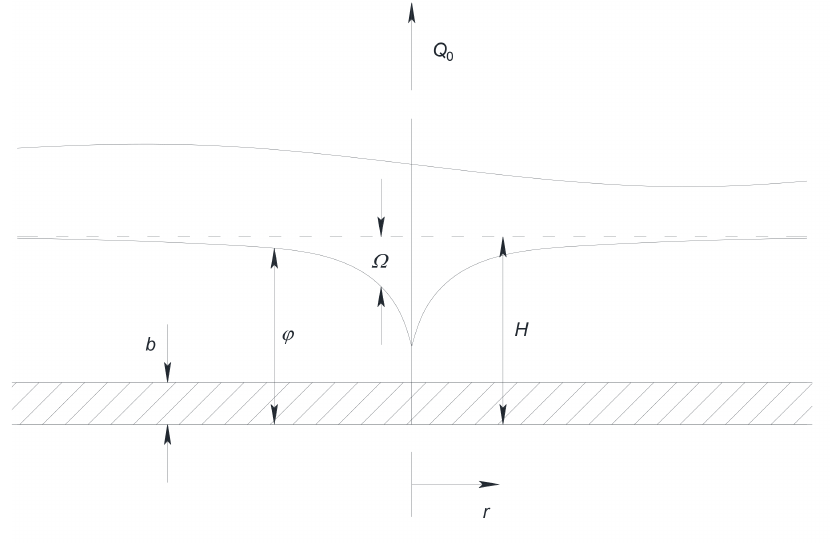
Figure 1. Sketch of the